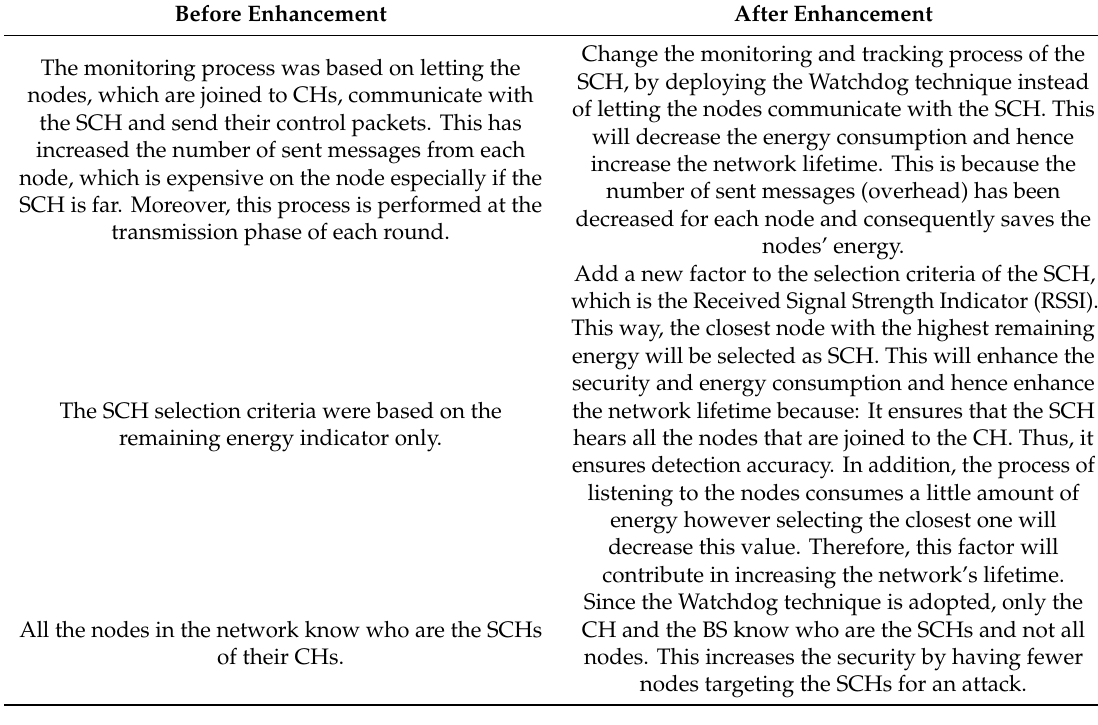
Table 2. Analysis of algorithm’s enhancements.